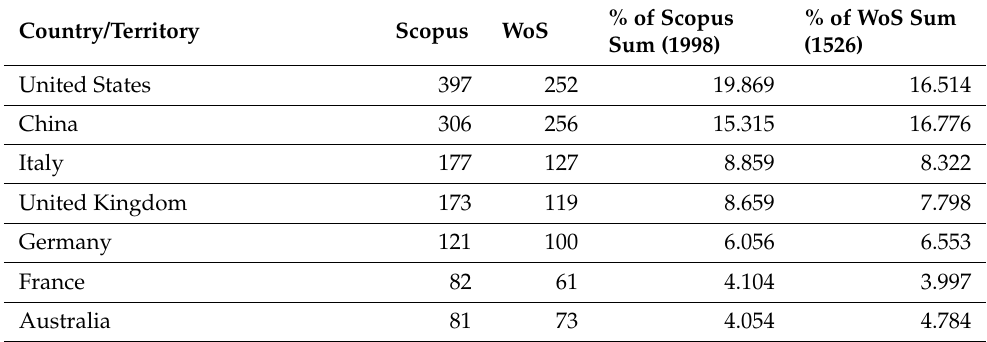
Figure 23. The global research activities showing countries with the highest relevance for “additive manufacturing on lattice structures”. Table 5. The global research activities showing countries with the highest relevance for “additive manufacturing on lattice structures” from the Scopus and WoS databases.